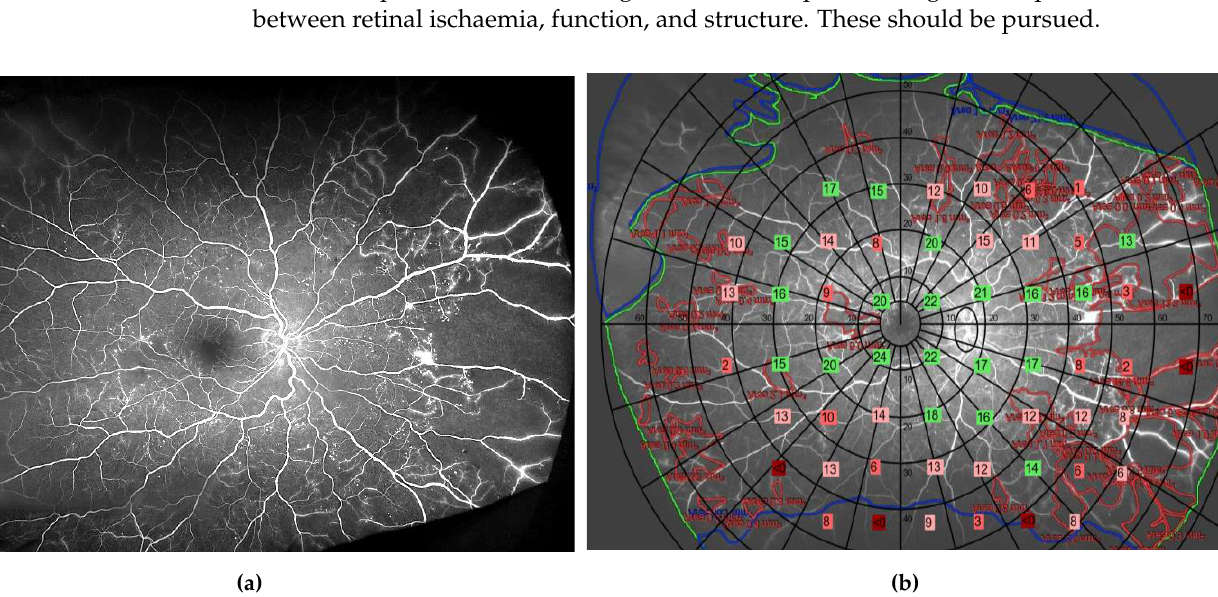
Figure 6. Ultrawide field fundus fluorescein angiogram ( a ) and same image with superimposed sensitivity values as derived from the Metrovision automated perimeter (57-point static test) ( b ). In green are depicted points with normal sensitivity; in light pink are those with deficits from 4 to 8 dB; in dark pink are deficits of >8 dB; and in red absolute deficits, when compared with those obtained in the corresponding locations in an age-matched group of healthy volunteers.